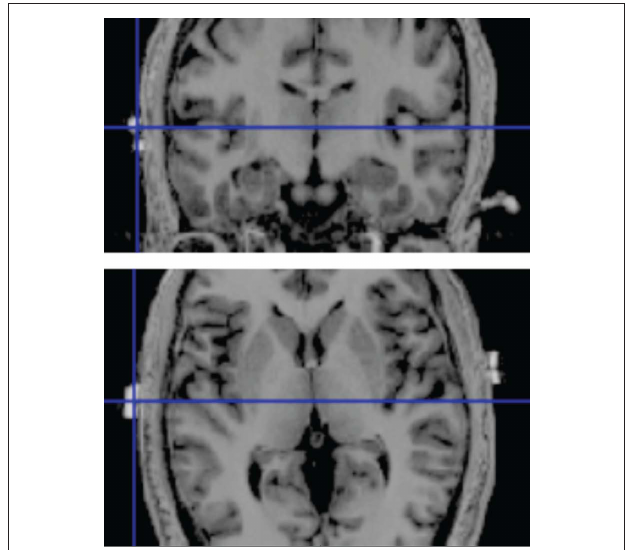
Figure 1 | High resolution T1-weighted image of a single subject with Mri compatible markers placed over the skull position of Hg. Top: coronal section; bottom: axial section. The markers show a good correspondence between the electrode position and the presumed skull position of